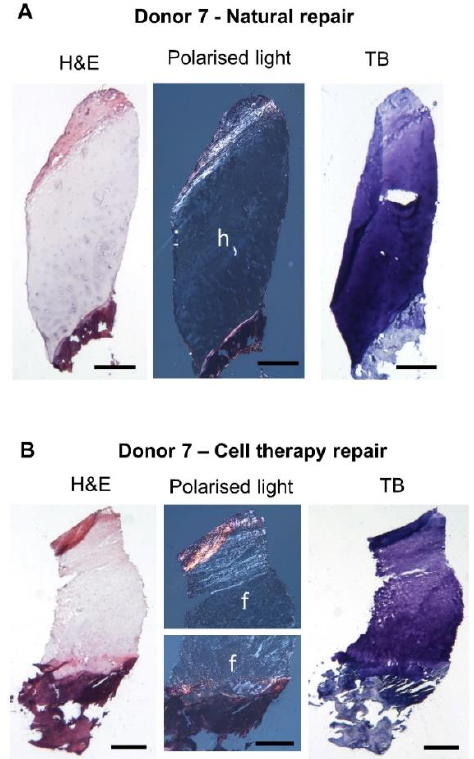
Figure 1. Representative histology images of cartilage repair biopsies from the same donor. Natural repair ( A ) and cell therapy repair ( B ) cryosections were stained with haematoxylin and eosin (H&E) to assess general morphology and toluidine blue (TB) to assess proteoglycan content; both samples demonstrated good to excellent matrix metachromasia. Polarised light was used to assess collagen fibre orientation and determine tissue morphology. The natural repair cartilage demonstrated a mostly hyaline (h) morphology whilst the cell therapy repair cartilage was mostly fibrocartilage (f). Scale bars 500 μm.